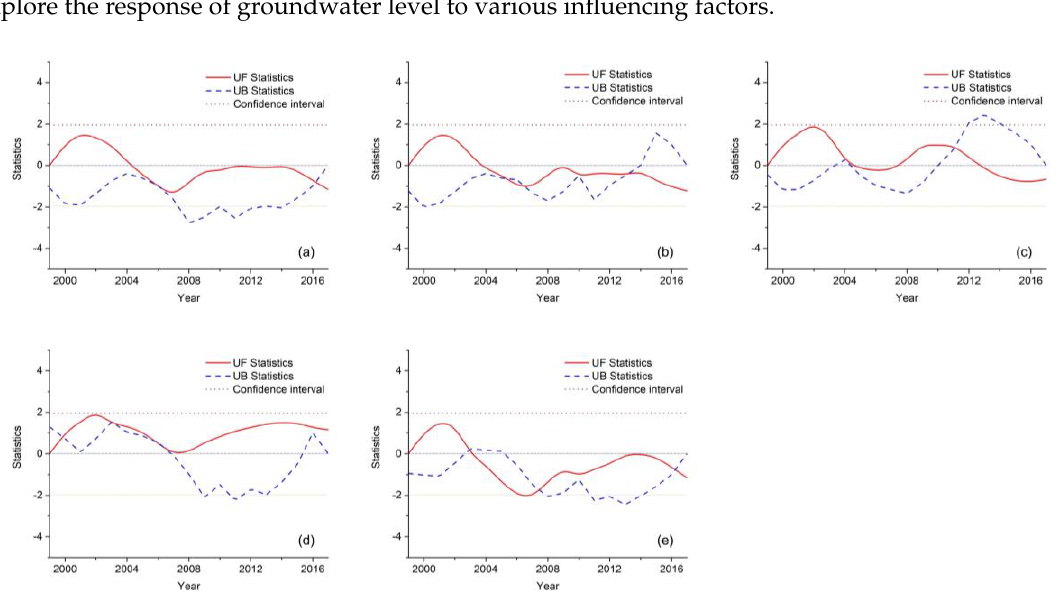
Figure 10. Groundwater level variation trends of the M–K test from 1999 to 2017 in Karakalpakstan ( a ), Karauzyak ( b ), Kungrad ( c ), Muyanak ( d ), Nukus ( e ).